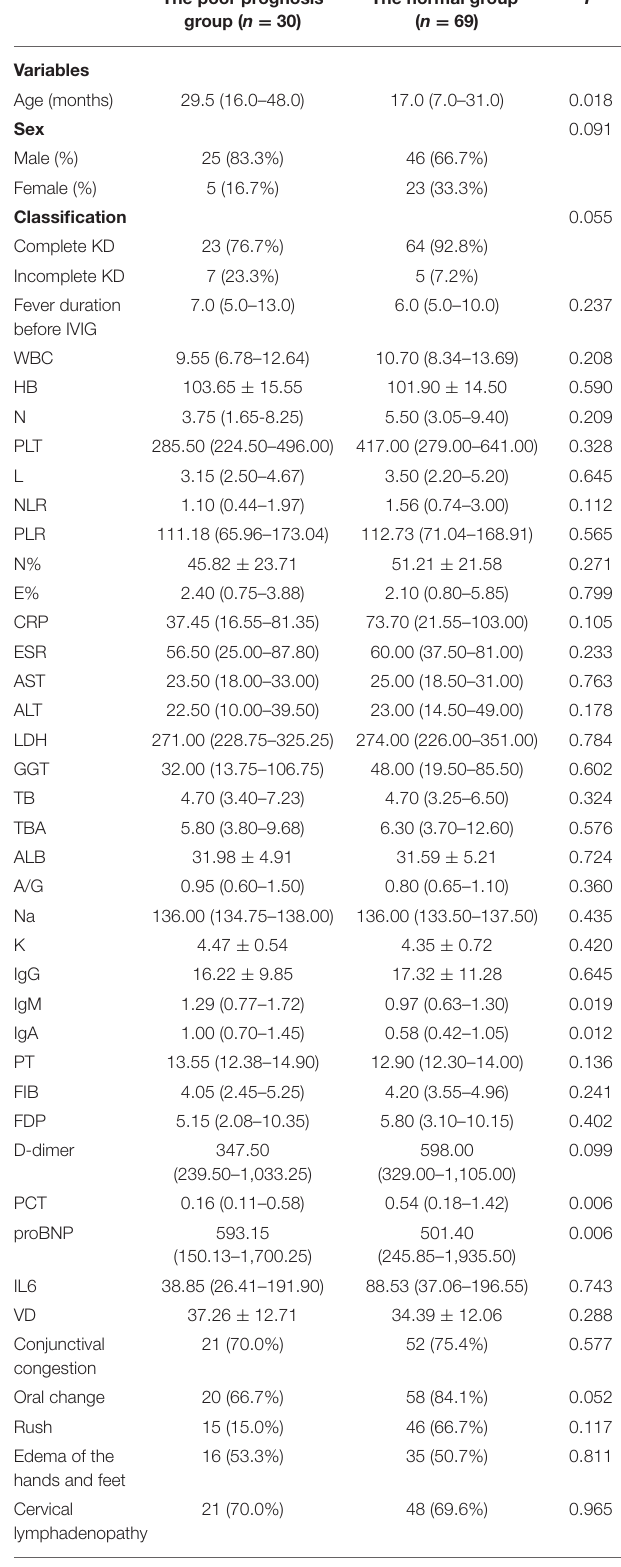
TABLE 3 | Univariate analysis for risk factors of prognosis. The poor prognosis The normal group group ( n = 30) ( n = 69)